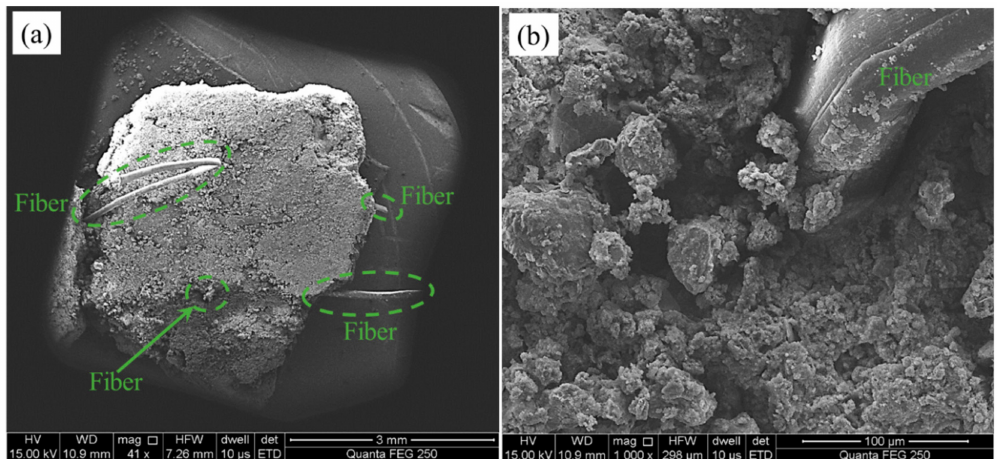
Figure 10. SEM micrographs of the fiber-reinforced CPB with di ff erent scales: ( a ) 3 mm; ( b ) 100 µ